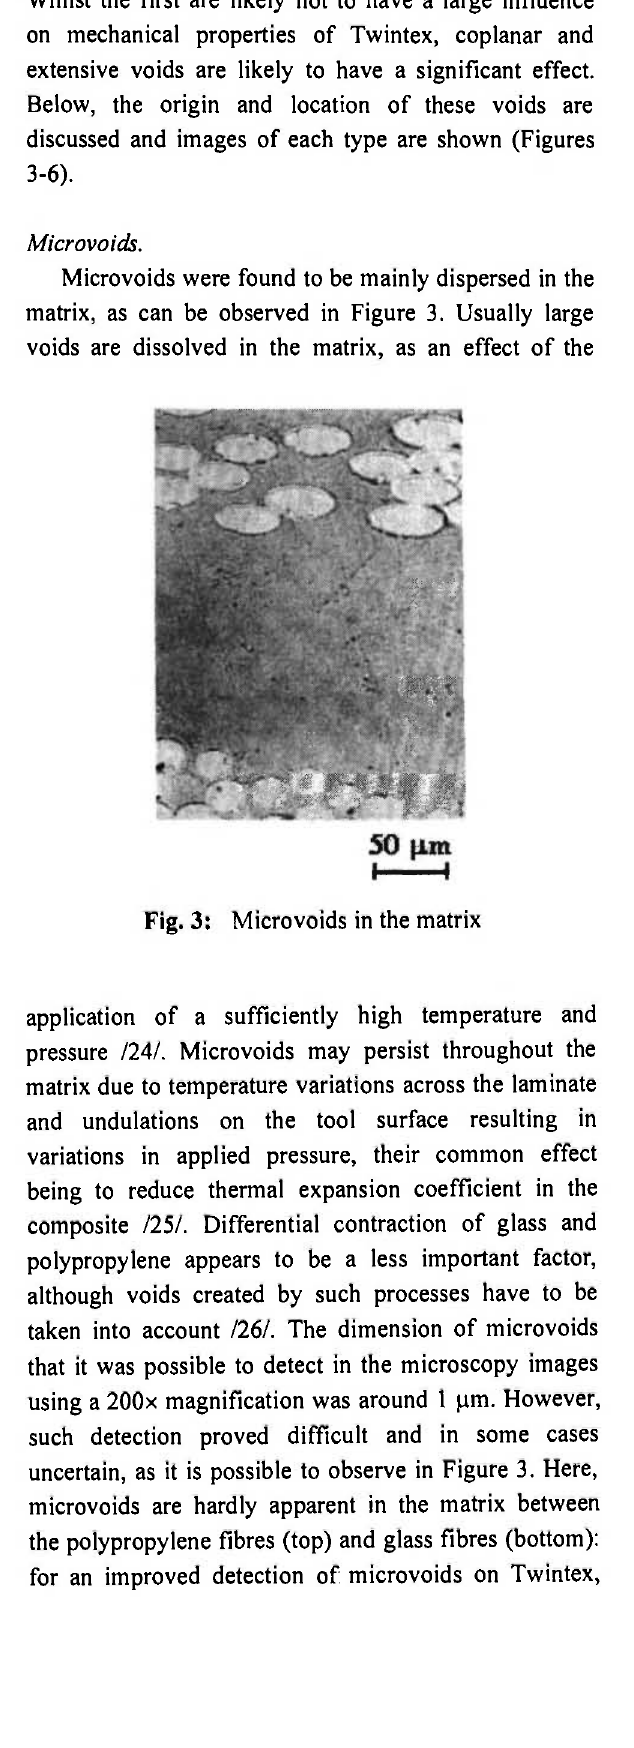
Fig. 3: Microvoids in the matrix